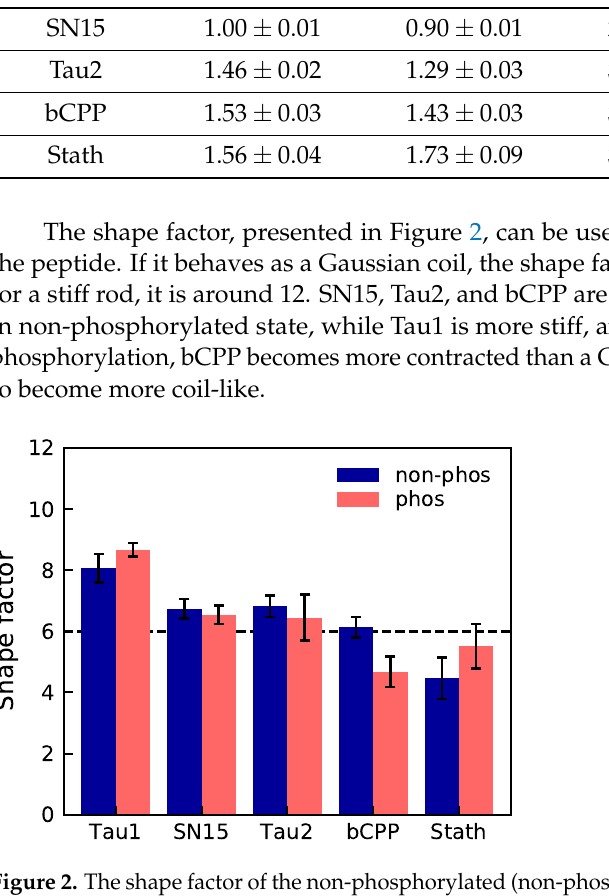
Figure 2. The shape factor of the non-phosphorylated (non-phos) and phosphorylated (phos) variants. The dashed line corresponds to the shape factor of a Gaussian coil. The error bars are based on error propagation of the error estimates determined for radius of gyration and end-to-end distance by block